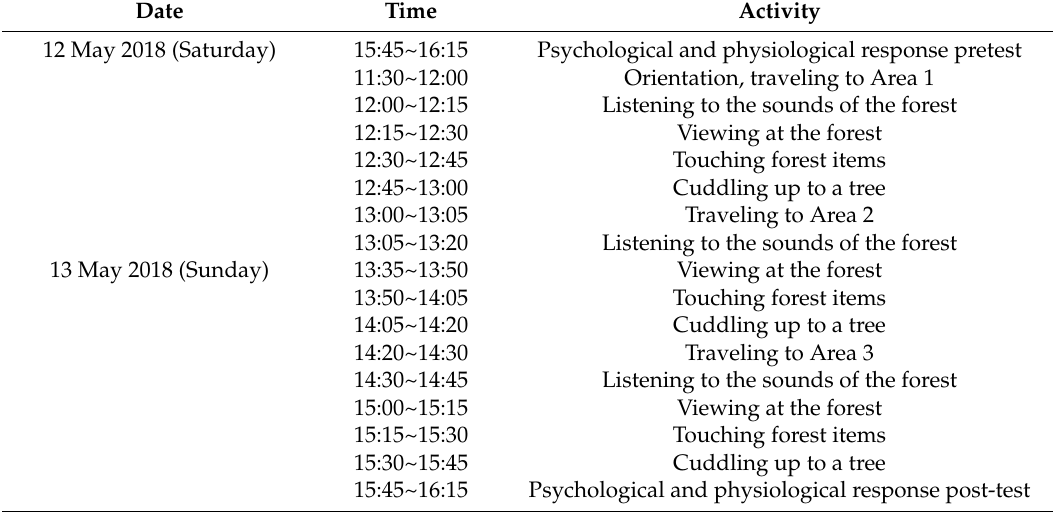
Table 3. Schedule of the indoor (first day) and field (second day)